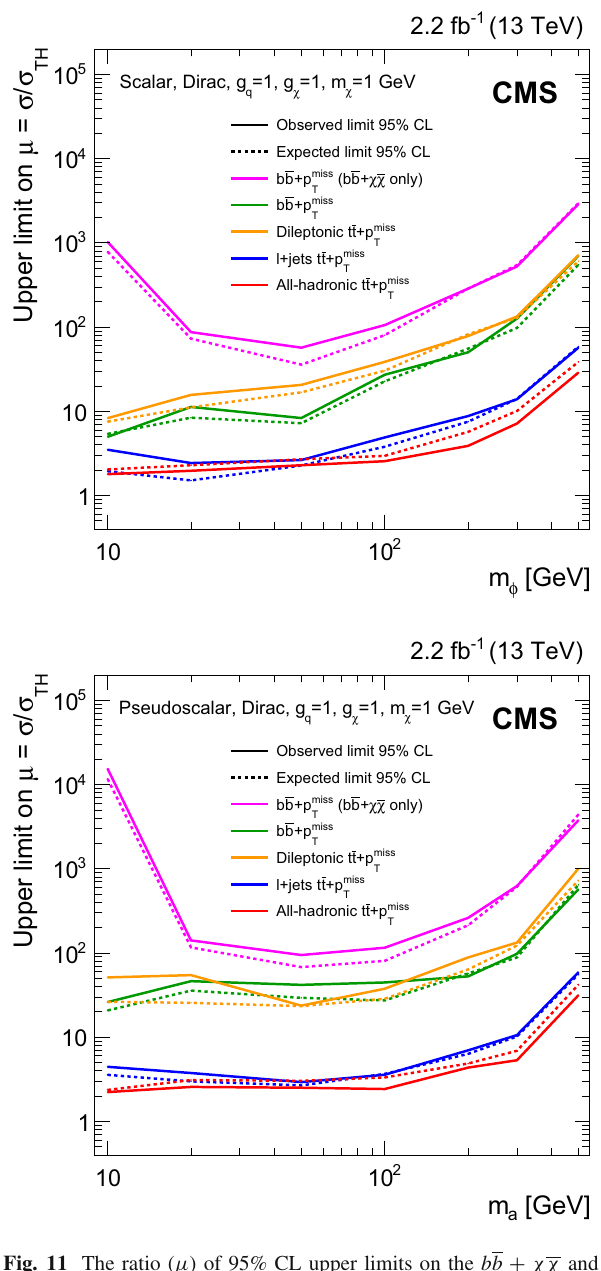
Fig. 11 The ratio ( μ ) of 95% CL upper limits on the bb + χχ and tt + χχ cross sections to simplified model expectations. The limits are obtained from fits to the individual bb + p miss channels for the hypothesis of a scalar mediator (upper) or a pseu- doscalar mediator (lower). A fermionic DM particle with a mass of 1 GeV is assumed in both panels. Mediator couplings correspond to g q = g χ =